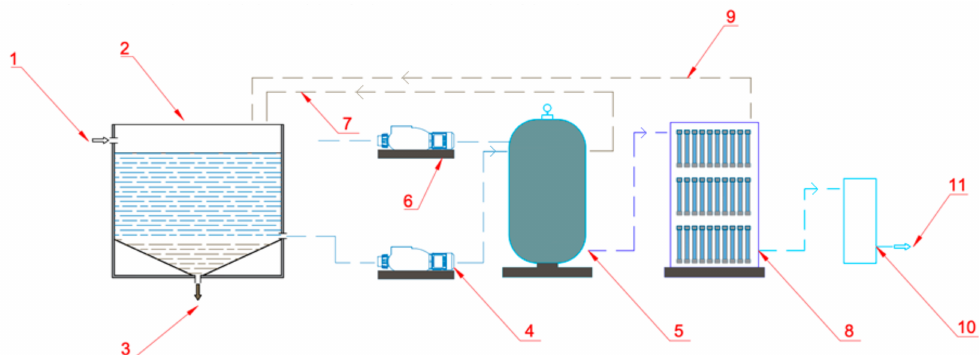
Figure 9. Installation for backwash water purification: 1—raw backwash water; 2—wash water reservoir—flocculation stage; 3—outflow to the sewage system; 4—circulation pump; 5—pre-filter filled with sand; 6—pre-filter pump; 7—backwash water from the pre-filter; 8—ultrafiltration system; 9-backwash water from ultrafiltration system; 10—tank with ozonation; 11—clean water for the swimming pool